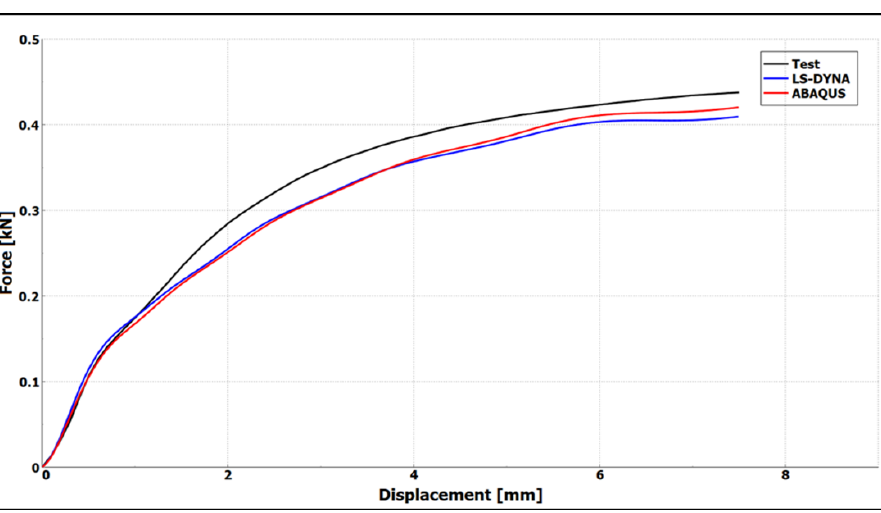
Figure 8. ( A ) 18650 cylindrical lithium-ion cell; ( B ) cell-cup model; ( C ) cell model also showing jellyroll. The material used to simulate the cell cup is a steel model. Shell thicknesses, as mentioned above, vary between 0.23 mm and 0.31 mm.